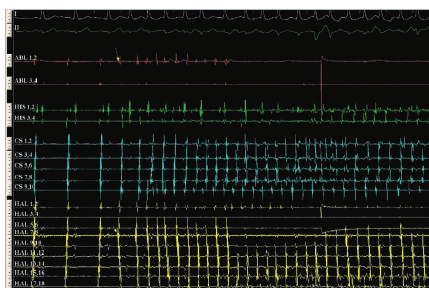
Figure 3: The deflectable 20-polar catheter is placed in the tri- cuspid annulus in order to perform a linear lesion in the cavo- tricuspid isthmus. Atrial extrasystoles produced with each movement of the catheters in the right atrium trigger